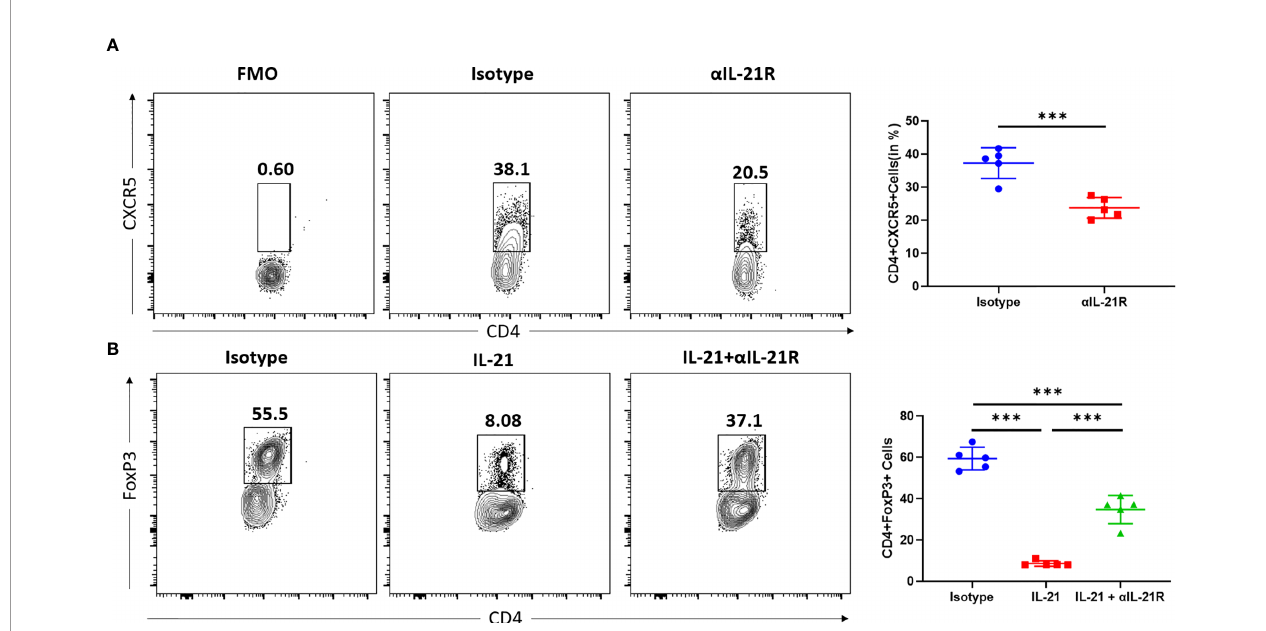
FIGURE 2 | a IL-21R inhibits Tfh cell differentiation and rescues the IL-21 induced inhibition in Treg cells. (A) Naïve CD4+ T cells were isolated from C57BL/6 mouse and cultured under Tfh condition in the presence of 10 m g/ml a IL-21R or Isotype control. Frequencies of CD4 + CXCR5 + Tfh cells were analyzed by fl ow cytometry. (B) Naïve CD4 + T cells were isolated from C57BL/6 mouse and cultured under Treg condition, in the presence of 10ug/ml IL21, with a IL-21R or Isotype control. Frequencies of CD4 + FOXP3 + Treg cells were analyzed by fl ow cytometry. Column plots display individual data points and mean ± SD, n = 5/group. Fluorescence minus one (FMO) controls are the experimental cells stained with all the fl uorophores minus the fl uorophore of target. FMO controls were used to properly interpret fl ow cytometry data.